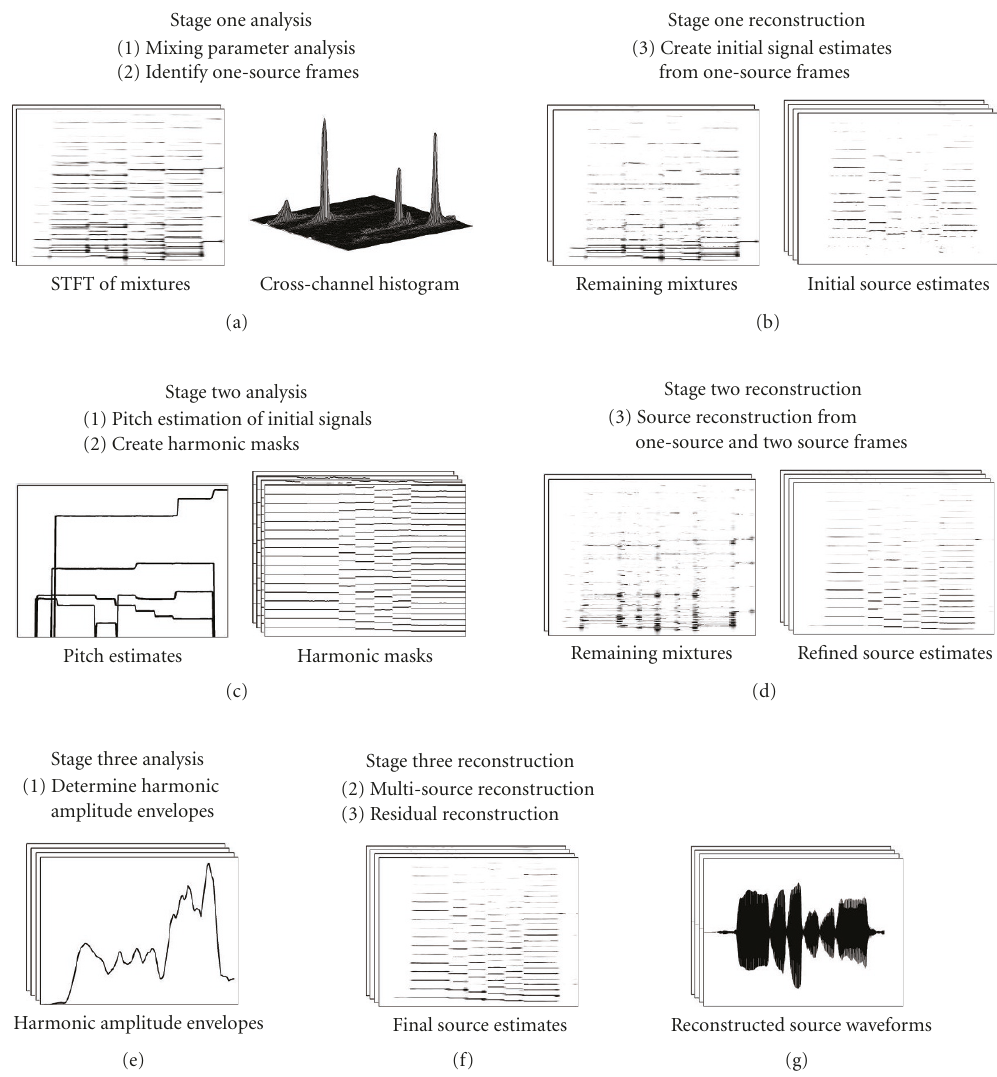
Figure 2: An illustration of the three stages of the proposed source separation